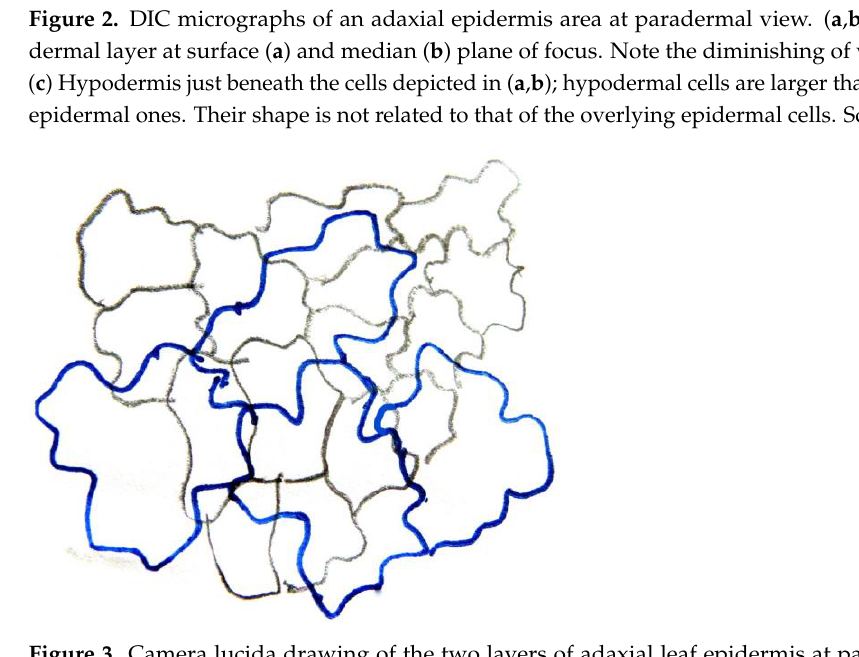
Figure 3. Camera lucida drawing of the two layers of adaxial leaf epidermis at paradermal view. External epidermal cell contours appear in black and hypodermal cell contours in blue. The cell contour of each layer is unrelated to that of the other.